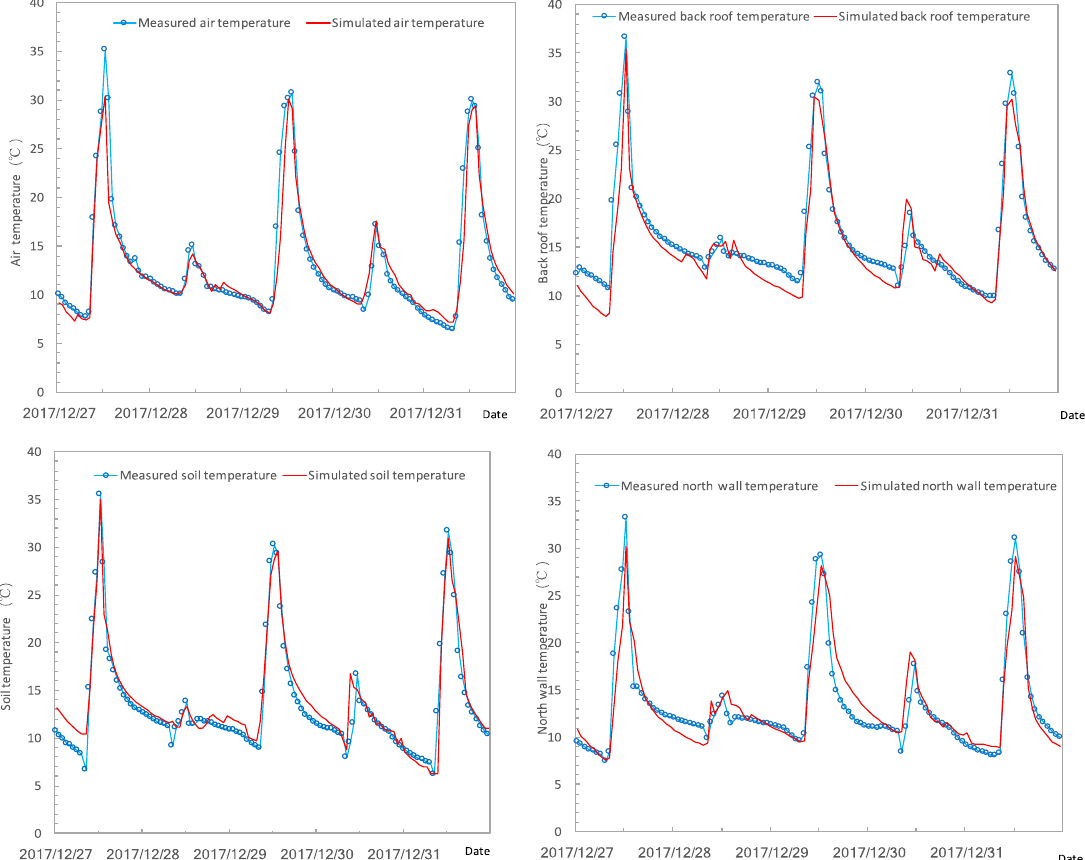
Figure 11. Comparisons of simulated and measured temperature variations during cloudy days. The maximum air temperature difference between simulated and measured values appeared at noon with a range of 1.8–2.4 ◦ C for the clear days, which was a little higher than on a cloudy day, which had a range of 1.1–1.6 ◦ C. This was because the simulated data was the average temperature inside the greenhouse and the consistency of air temperature on cloudy days was higher than that on sunny